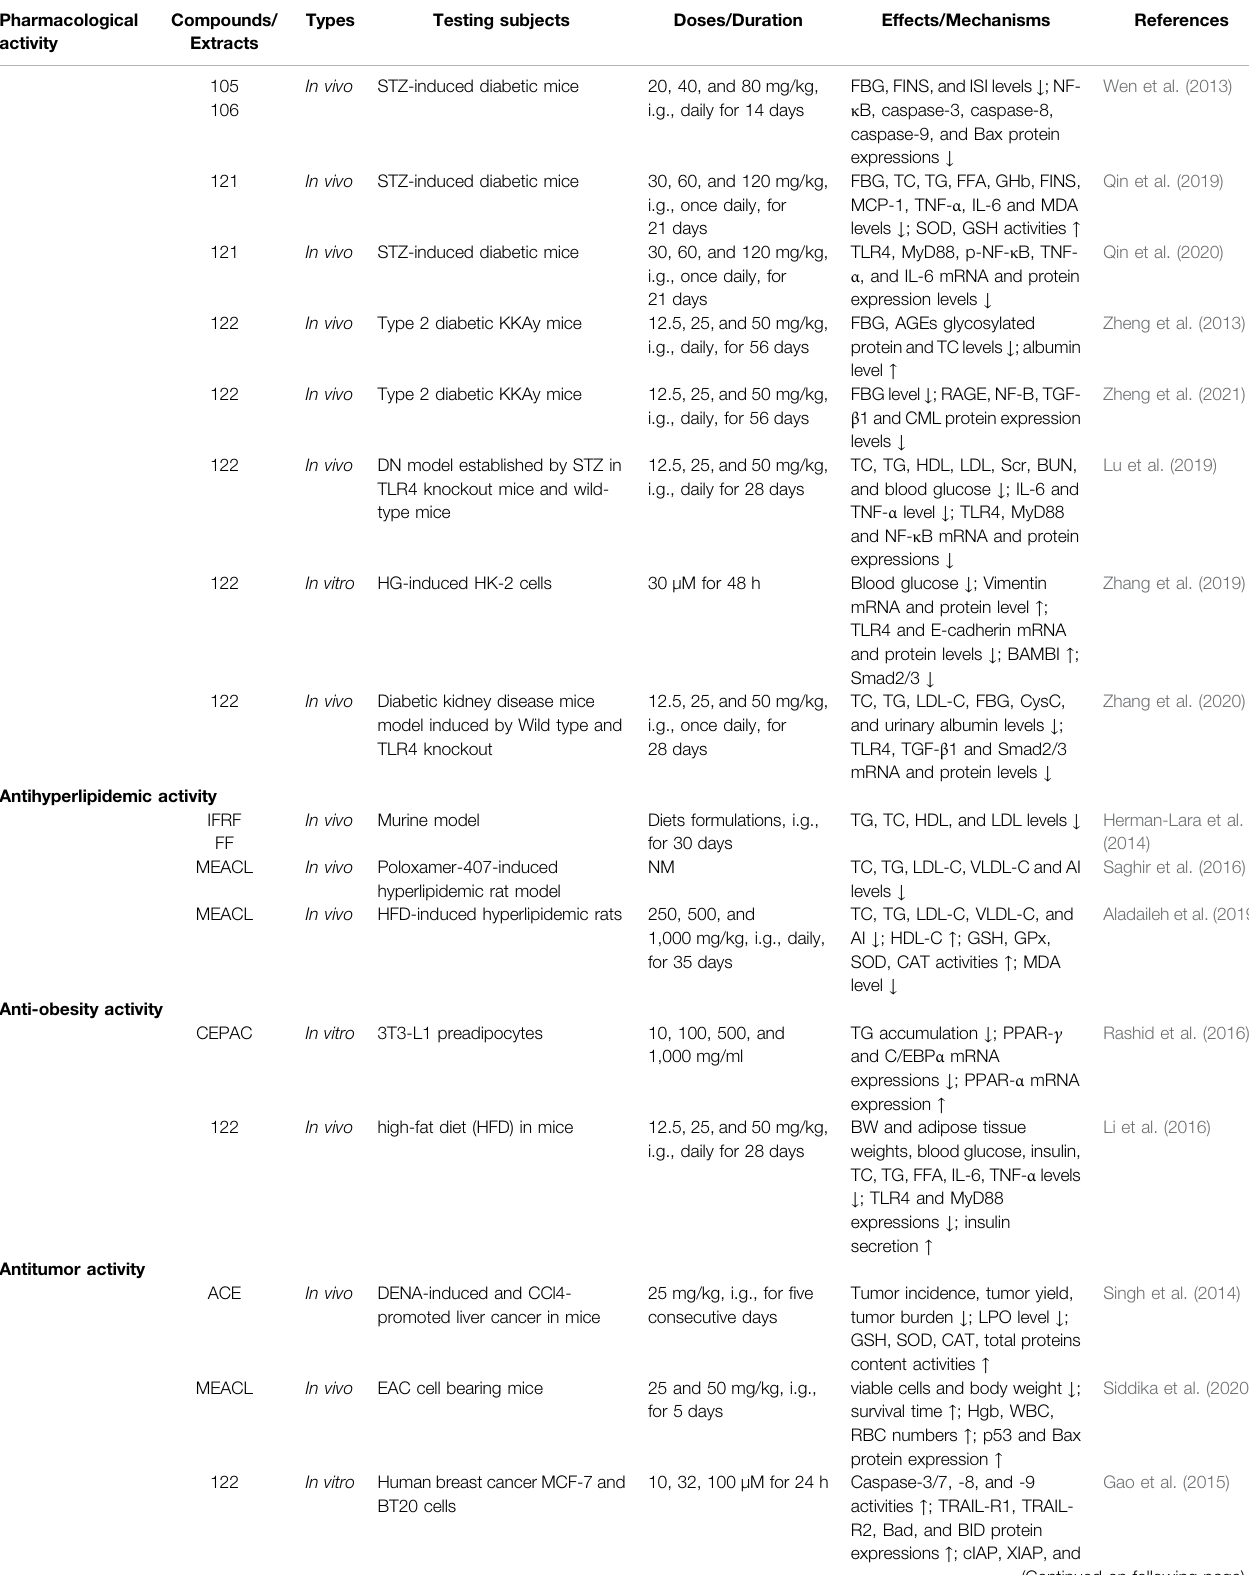
TABLE 2 | ( Continued ) Pharmacological effects of crude extracts and bioactive compounds of A. carambola